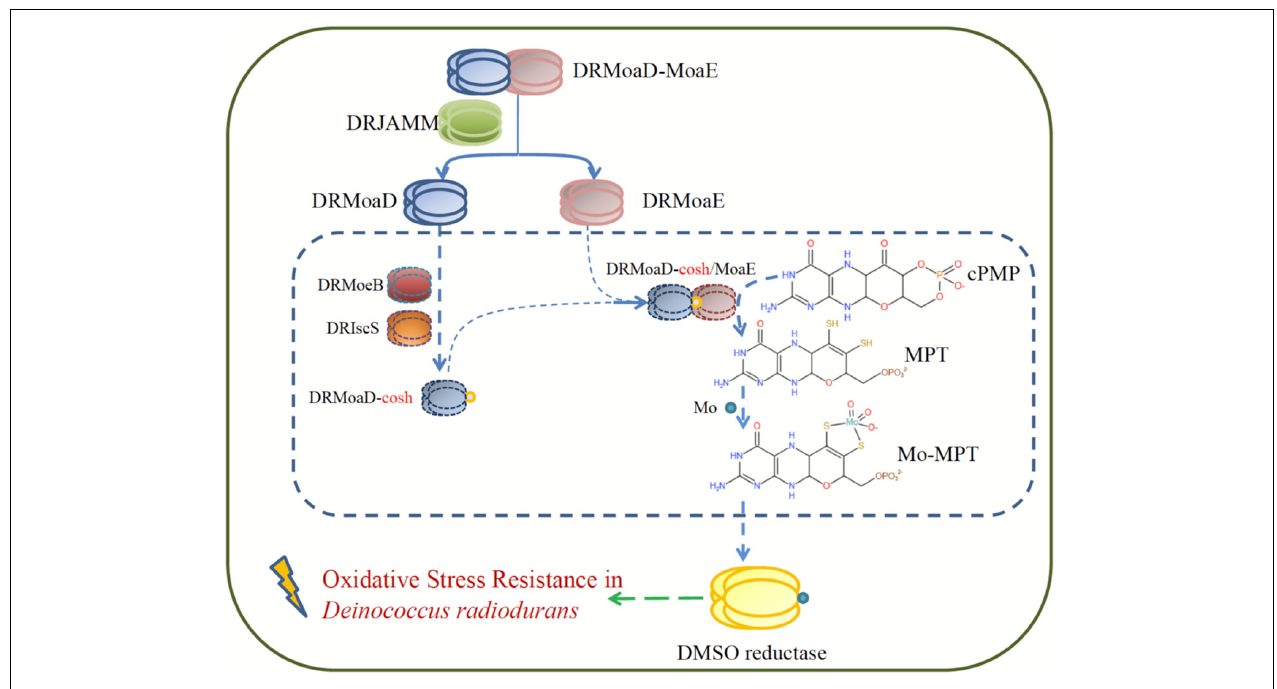
FIGURE 5 | A model of resistance to oxidative stress involving DRJAMM in D. radiodurans . Upon oxidative stress, DRMoaD-MoaE is cleaved by DRJAMM to produce DRMoaE and activates the DMSO reductase that participates in the antioxidant process of D. radiodurans through the Moco biosynthesis